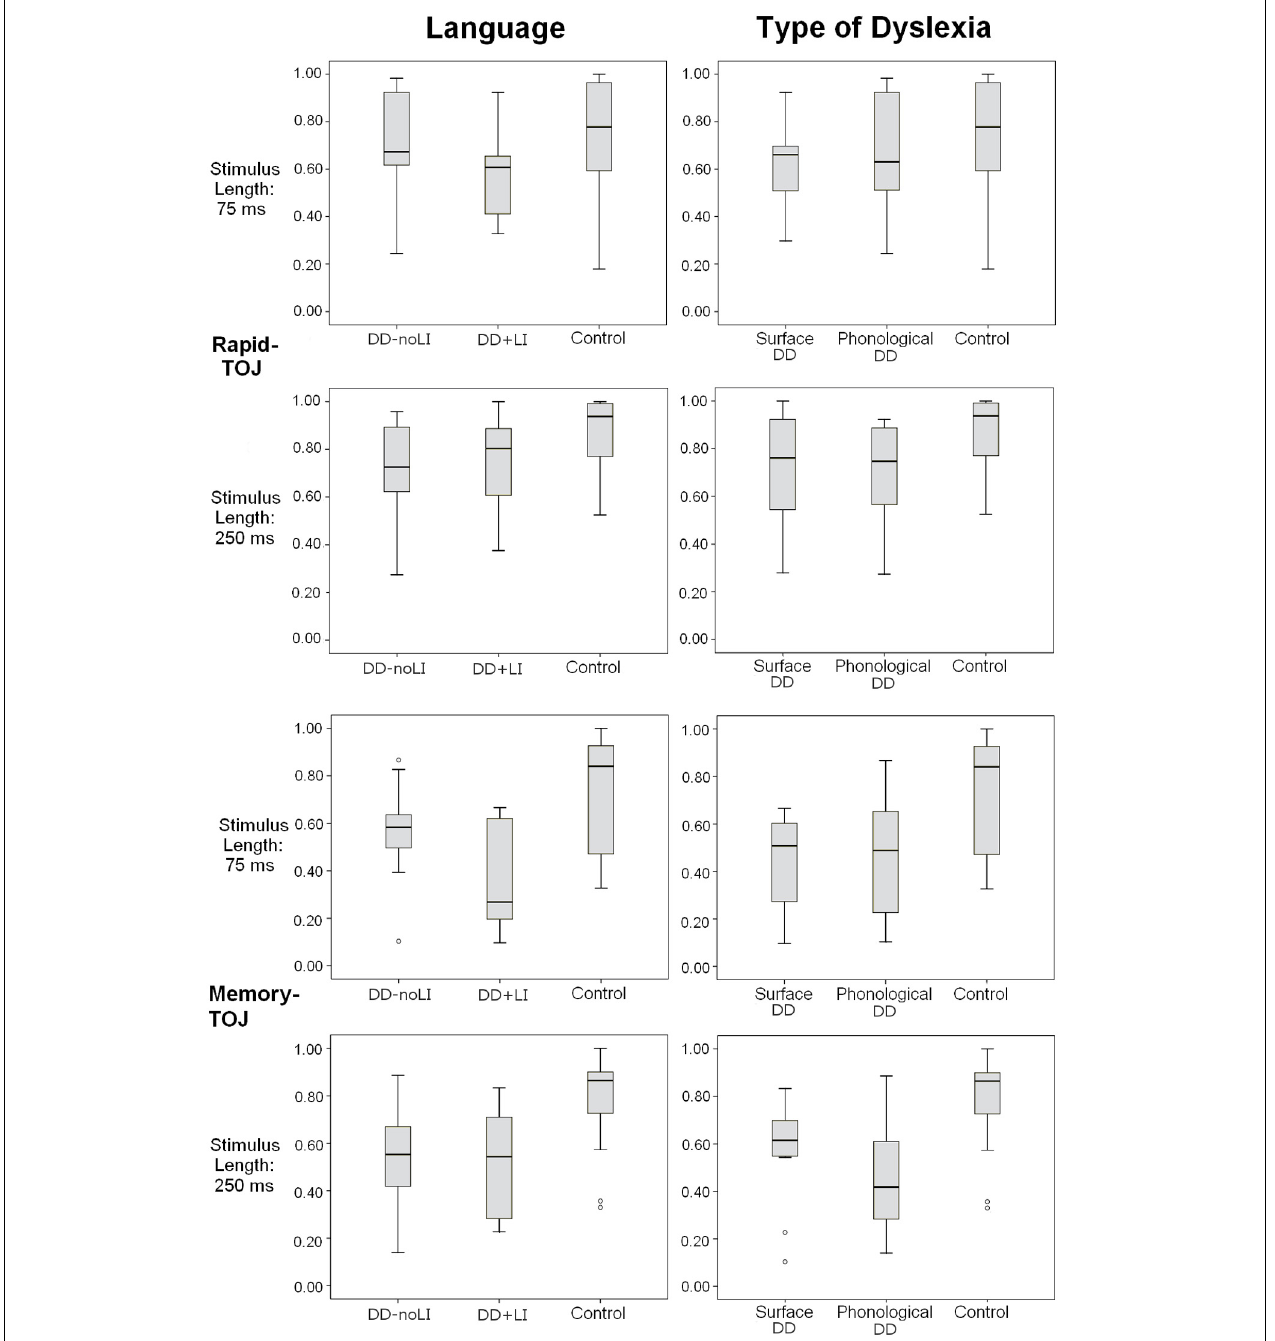
FIGURE 3 | Box plots displaying the distribution of individual scores in different subgroups (based on Language and Type of Dyslexia) for the Rapid-TOJ and the Memory-TOJ tasks. Empty circles correspond to outliers.